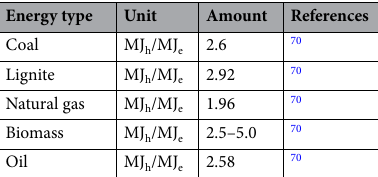
Table 4. Energy intensity data for fossil fuels extraction in the upstream flow.